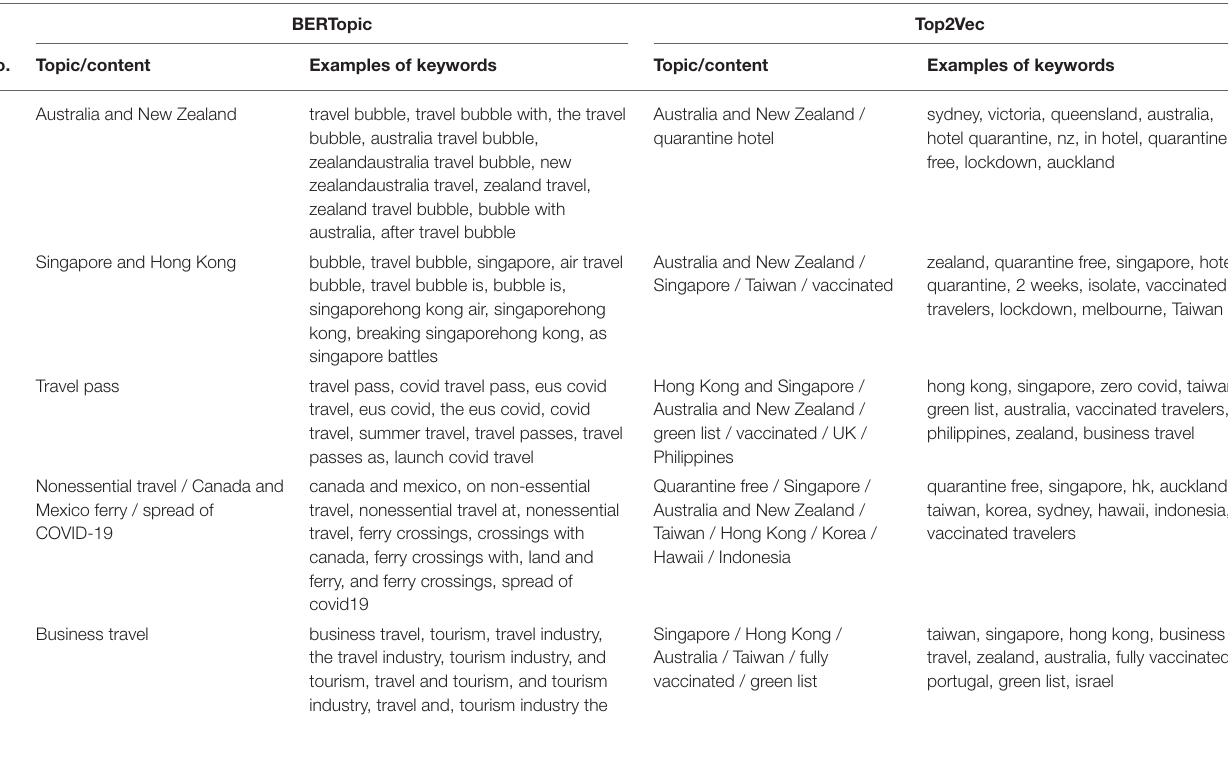
TABLE 3 | Topics identified by BERTopic and Top2Vec for “travel